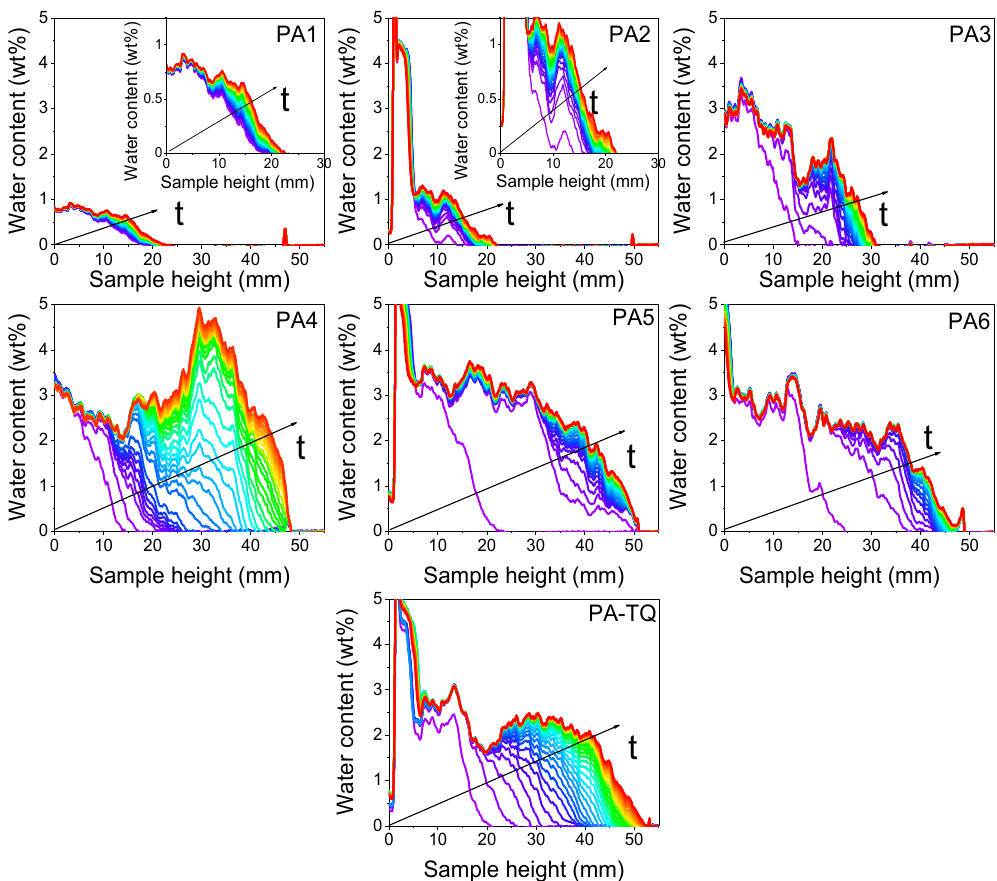
Figure 7. Water content profiles vs. sample height as obtained following the procedure described in Section 2.3. As already stated, neutron radiographs were collected every 40 s for all samples except for PA4, for which a time-step of 10 s was used. In our case, sample PA4 was measured for a total of 13,310 s, during which a water-saturated condition was achieved. For all the other samples, longer exposure times were necessary, since a slower water imbibition rate was observed after the initial stage of exposure with the water bath. For this reason, the water content profiles reported here were collected in the first ~13,310 s (3.7 h) of contact for